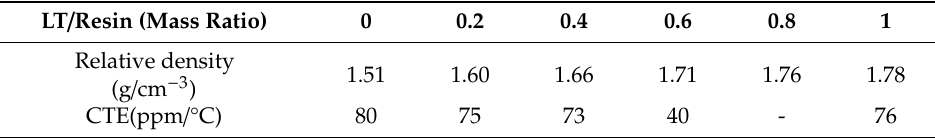
Table 1. The coe ffi cient of thermal expansions of Table 1. The coefficient of thermal expansions of LT-CCLs.